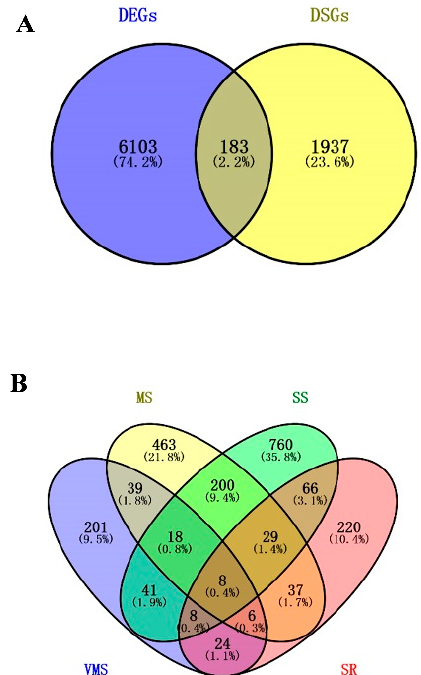
Figure 4. Venn diagram of differentially expressed genes (DEGs) and differentially spliced genes (DSGs). ( A ) Comparison analysis of overlapping between DEGs and DSGs under all drought conditions. ( B ) Comparison of DSGs under VMS, MS, SS, and SR conditions.